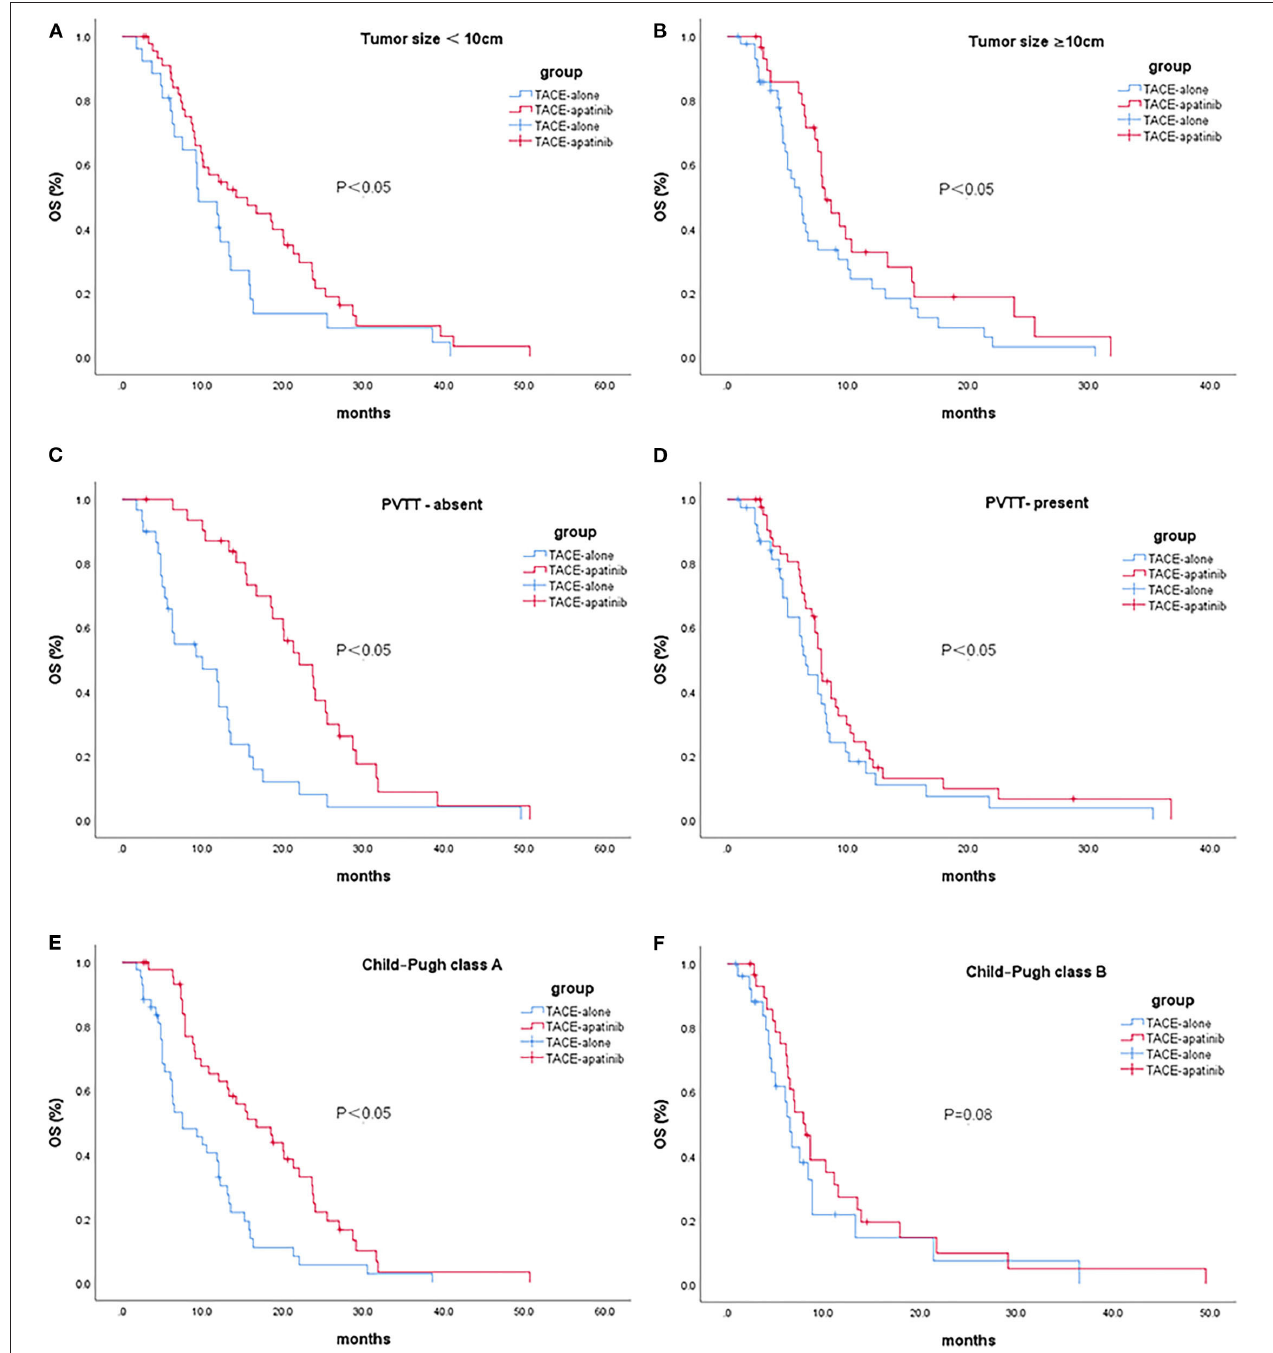
FIGURE 2 | Kaplan-Meier curves showed overall survival in the TACE-apatinib and TACE-alone groups in patients with BCLC stage C HCC [ (A) tumor size < 10cm, (B) tumor size ≥ 10cm, (C) PVTT-absent, (D) PVTT-present, (E) Child-Pugh class A, and (F) Child-Pugh class B].